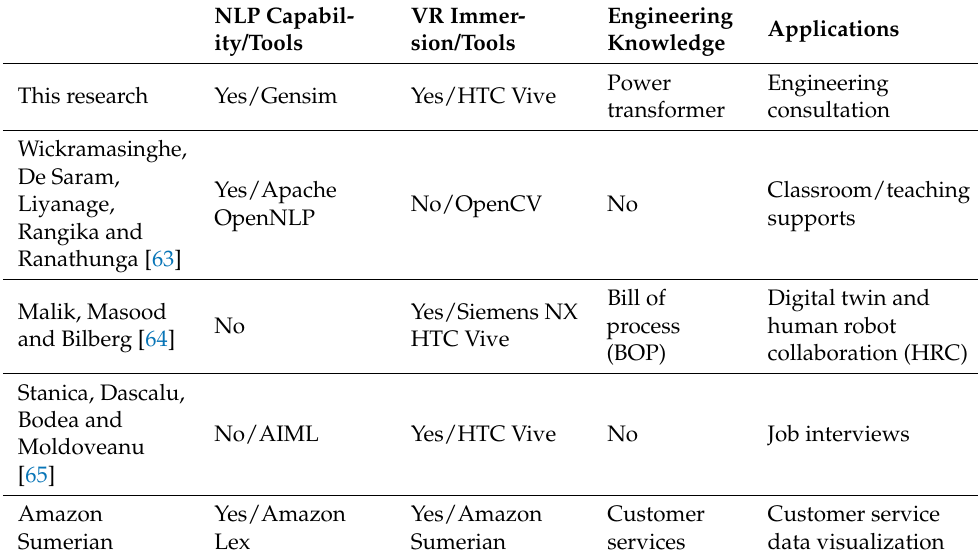
Table 7. The key capabilities of intelligent Chatbot research.